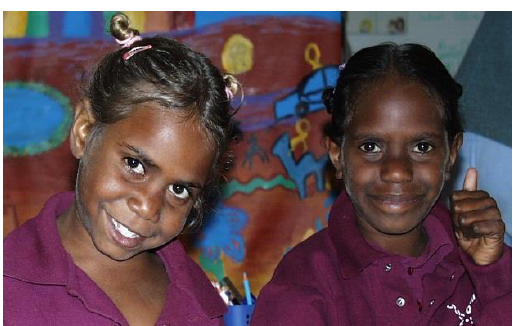
Figure 10. Participants in the